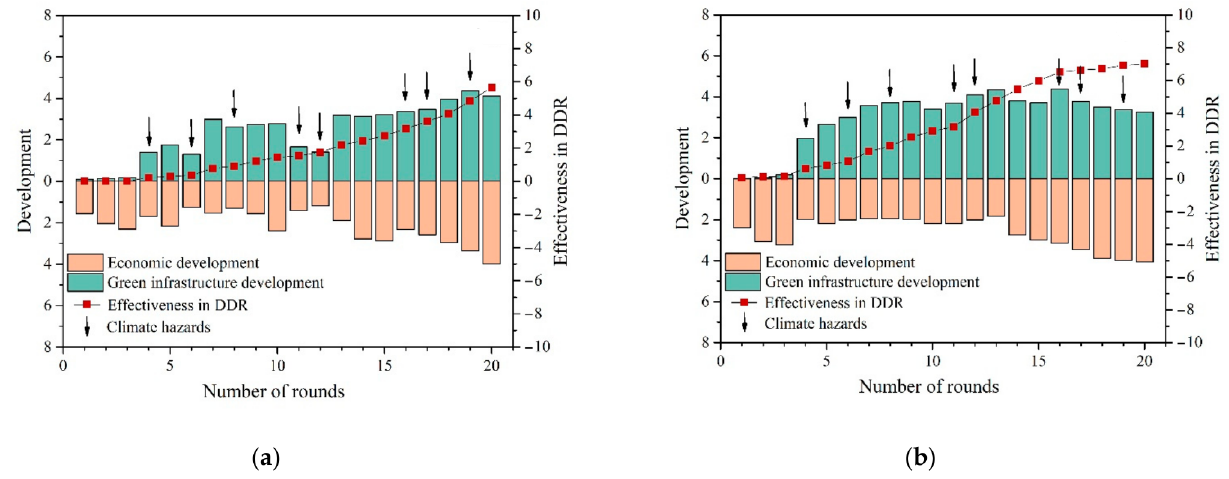
Figure 4. ( a ) Players’ decision making about trade-offs between development and DRR in T1; ( b ) players’ decision making about trade-offs between development and DRR in